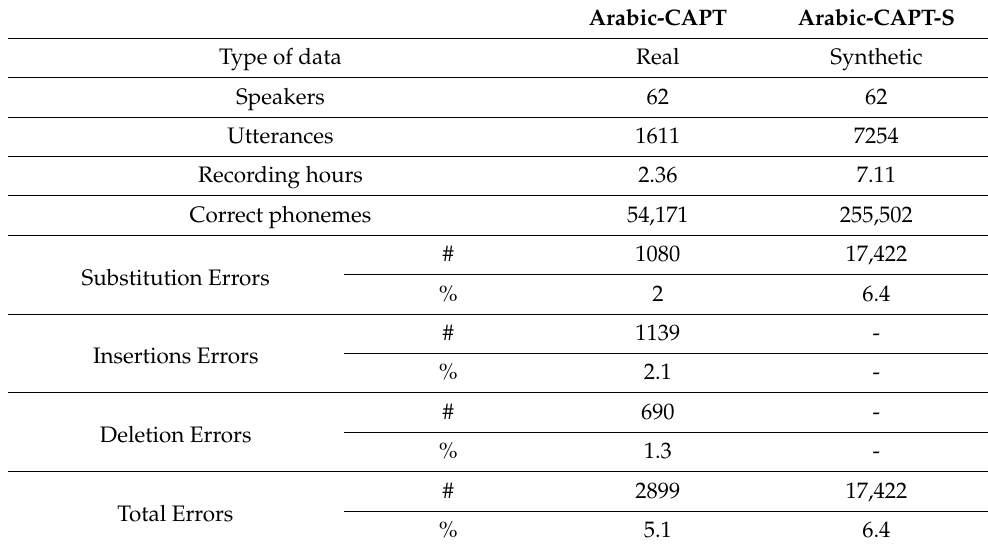
Table 3. Statistics of the developed